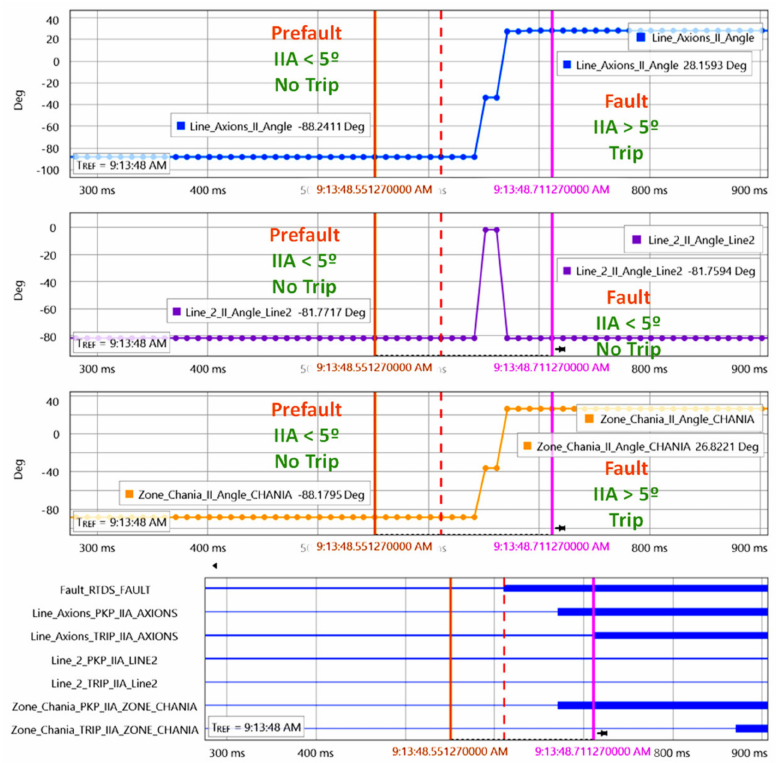
Figure 29. Line/Zone IIA behaviour; internal 1Ph fault at 30% of Line 1; Rfault = 0.01 Ω ; zero reactors